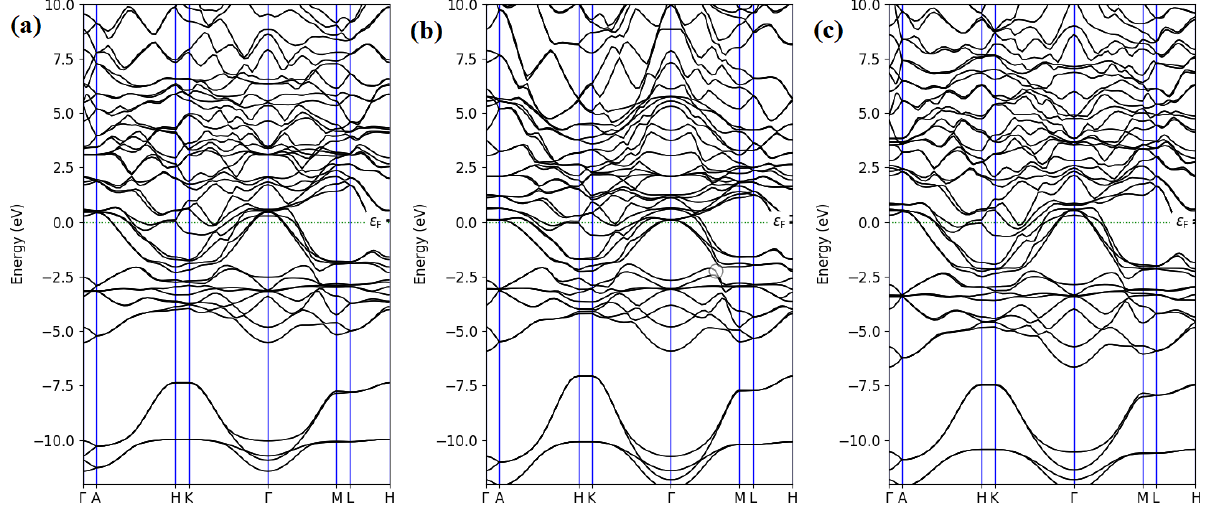
Figure 9. Electronic band structure of ( a ) Ti2PbC, ( b ) Zr2PbC, and ( c ) Hf2SnC with SOC contribution .